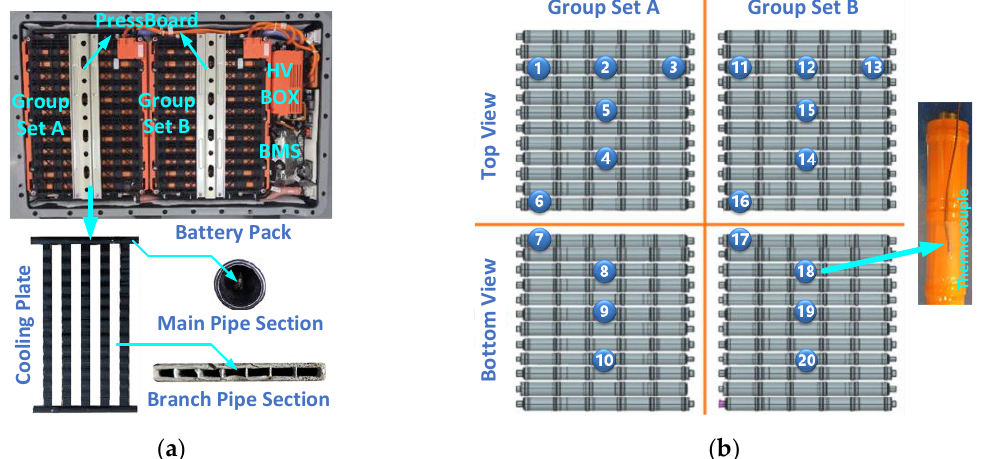
Figure 13. Battery pack with a cooling plate under a test: ( a ) the battery pack’s internal structure and the cooling plate in details; ( b ) the thermocouple placement and fixing method.